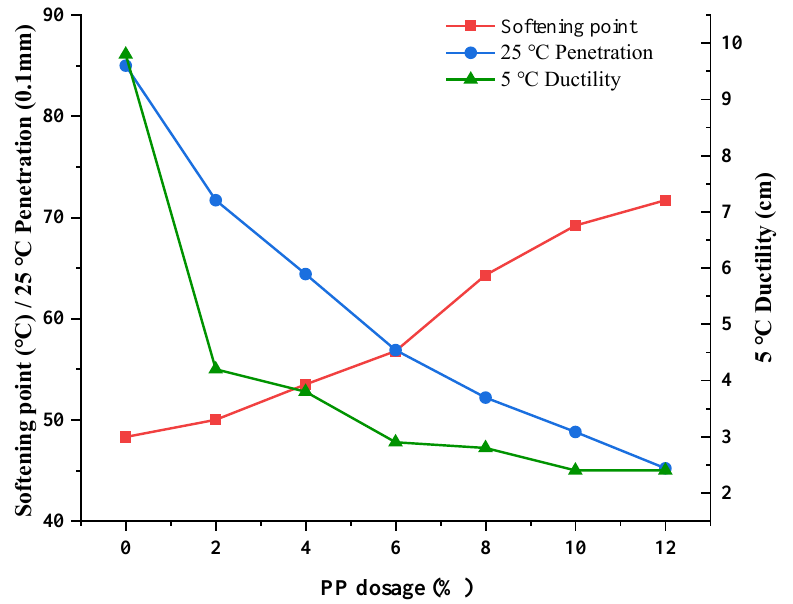
Figure 4. Influence curve of softening point, penetration, and ductility with different PP dosages.